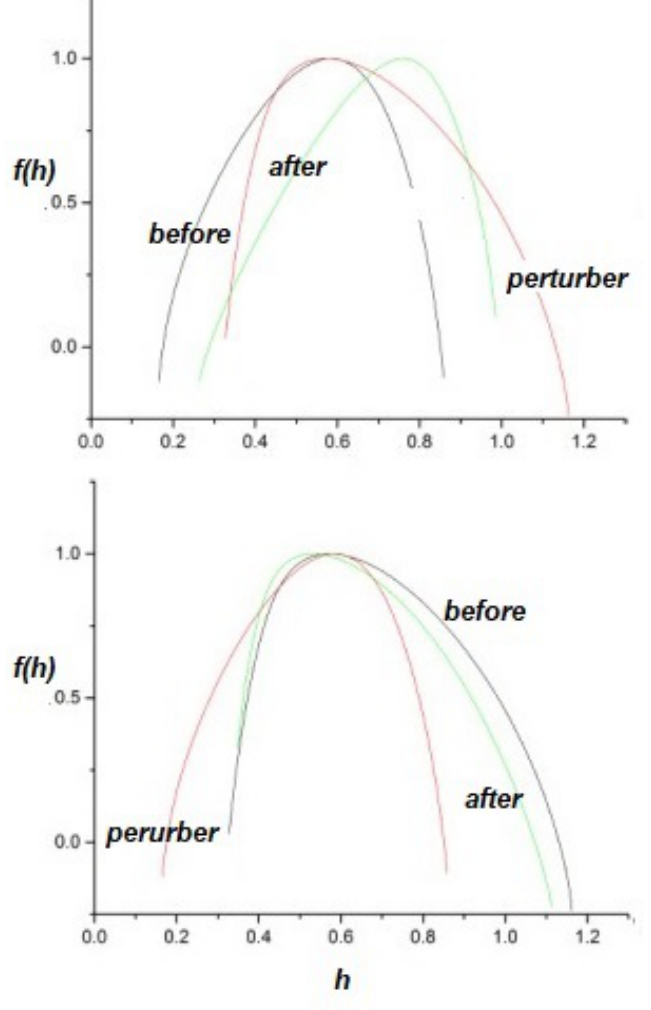
Figure 5. Effects of perturbation on the response network by a perturbing network, as captured by the multifractal spectra. ( Upper ): perturber having µ P = 1.2 perturbs network having µ R = 3.4 shown both before and after perturbation; ( Lower ): perturber having µ P = 3.4 perturbs network having µ R = 1.2 shown both before and after perturbation. The perturbation significantly changes the spectrum only when the IPL complexity index of the perturbed network is larger than that of the perturbing one. From [96] with